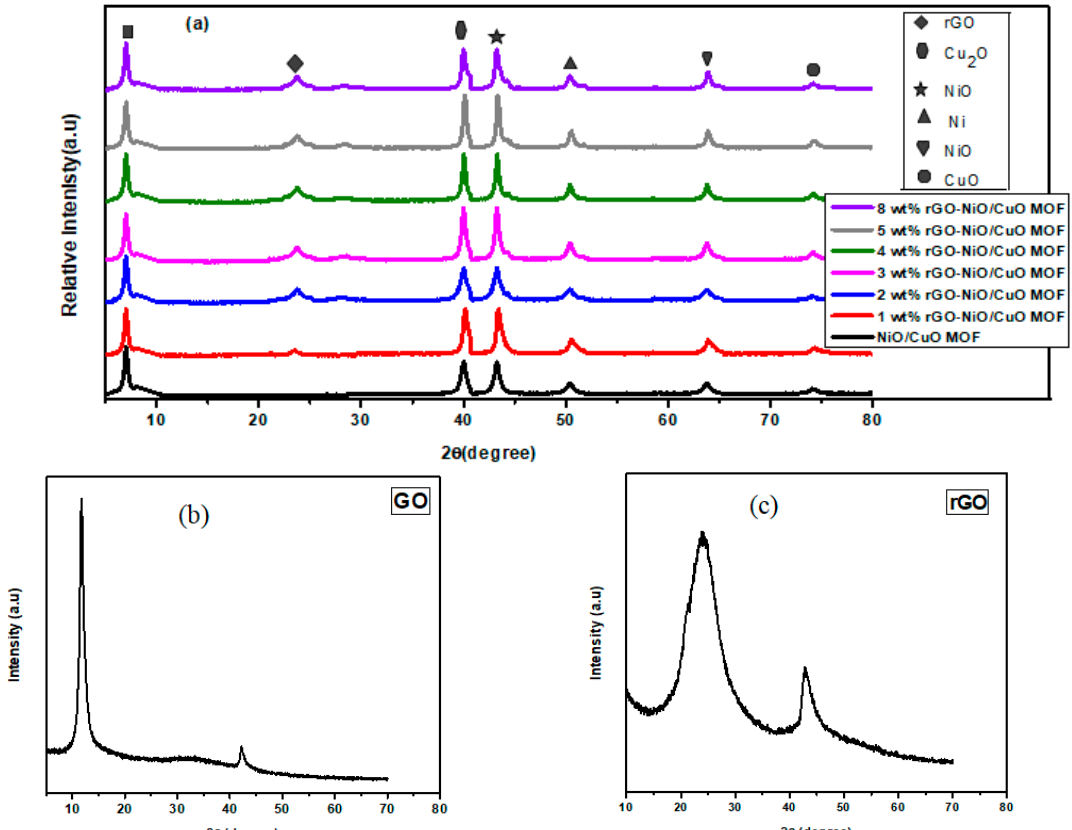
Figure 3. Powder XRD of ( a ) NiO / CuO MOF, 1 wt% rGO–NiO / CuO MOF, 2 wt% rGO–NiO / CuO MOF, 3 wt% rGO–NiO / CuO MOF, 4 wt% rGO–NiO / CuO MOF, 5 wt% rGO–NiO / CuO MOF and 8 wt% rGO–NiO / CuO MOF ( b ) graphene oxide ( c ) reduced graphene oxide.